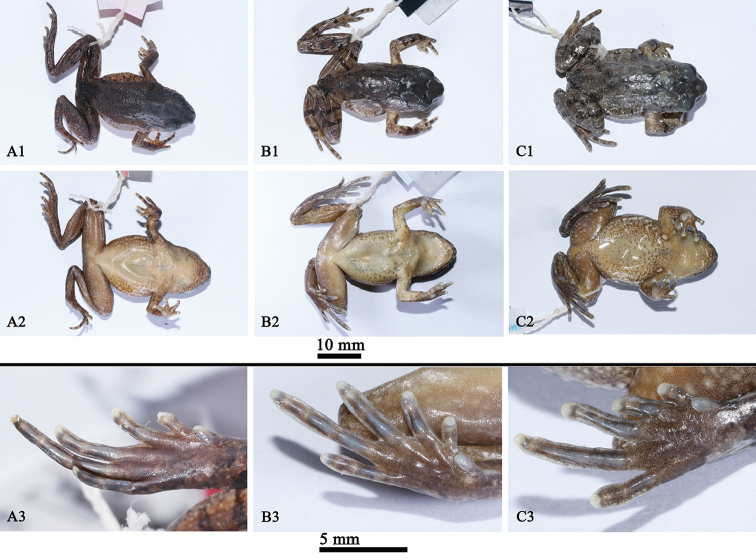
Specimens in preservative: A1–A3SYS a002957, the holotype of LeptobrachellalauiB1–B3SYS a005925, the topotype of L.liuiC1–C3SYS a004665, the holotype of L.yunkaiensis sp. n..